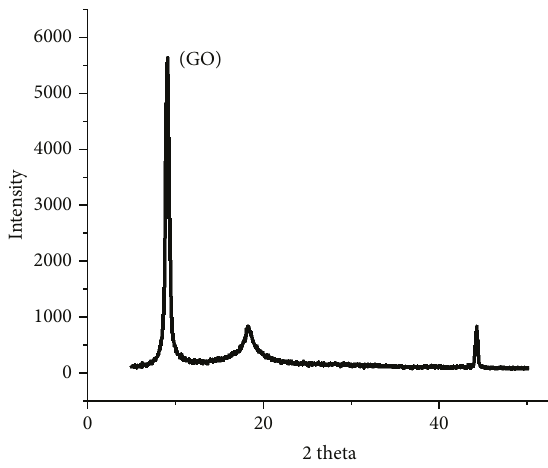
Figure 2: XRD pattern of the prepared graphene oxide